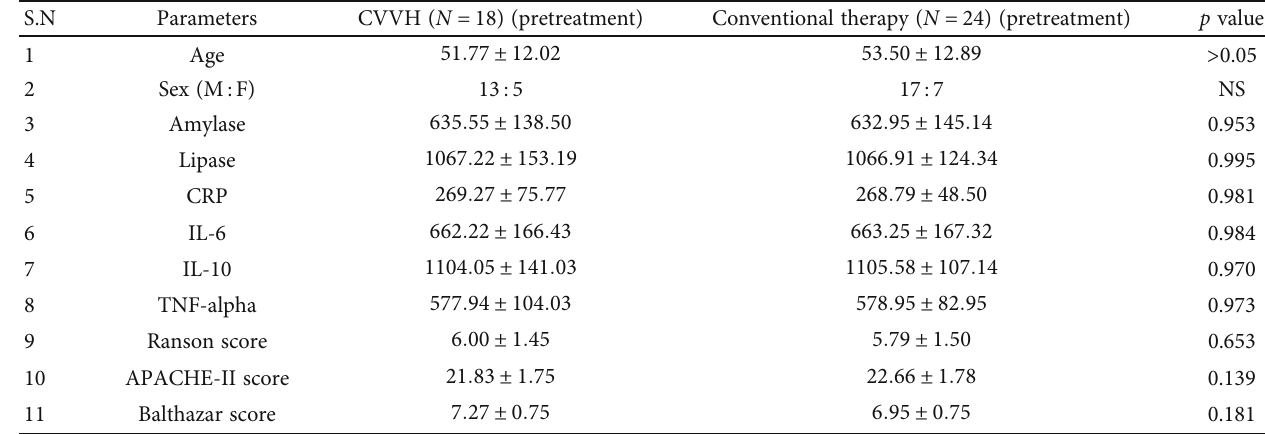
Table 2: Comparing baseline at the time of admission.